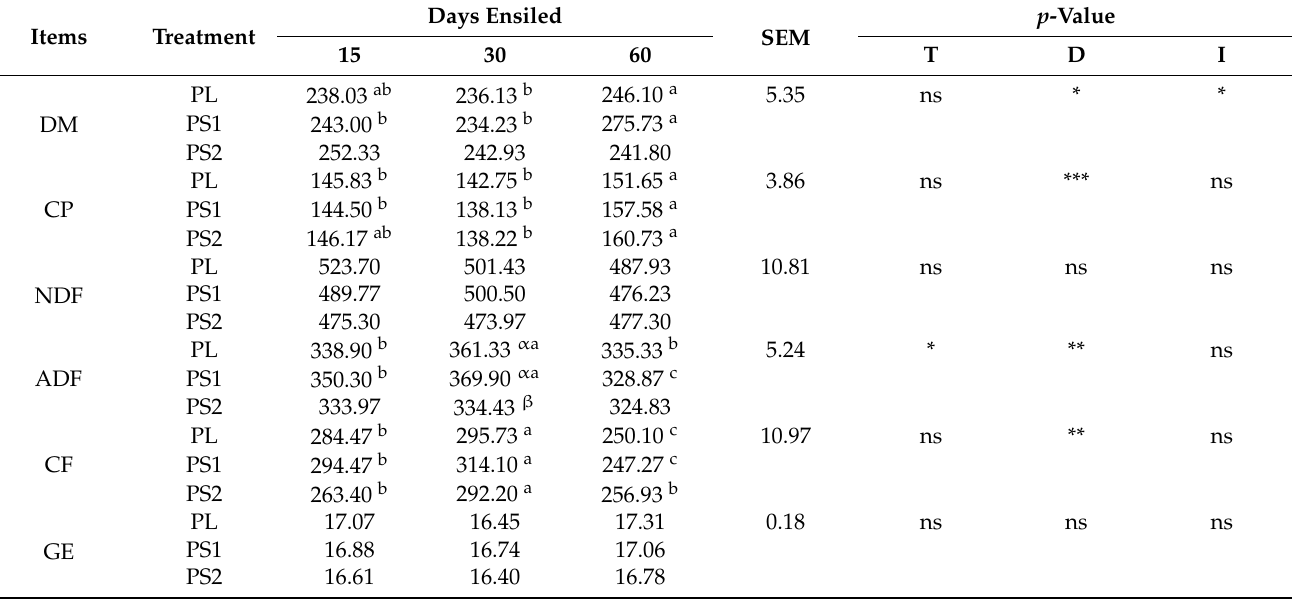
Table 1. Chemical compositions of the kudzu silages (g/kg DM).